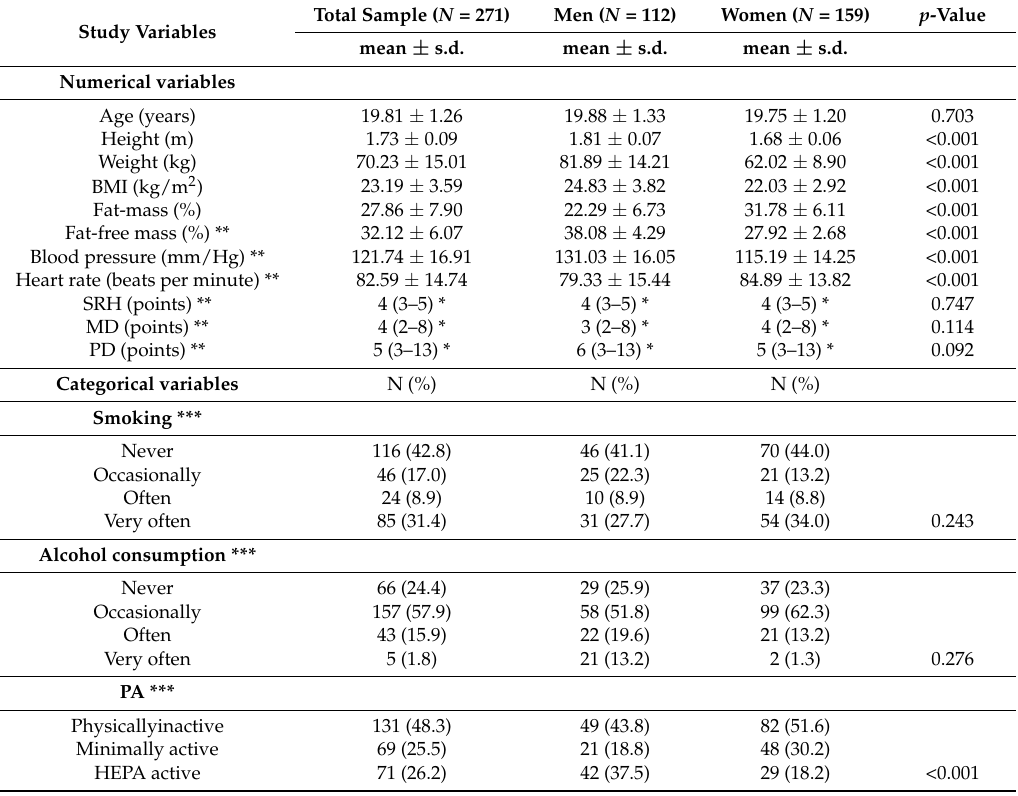
Table 1. Basic descriptive statistics of the study